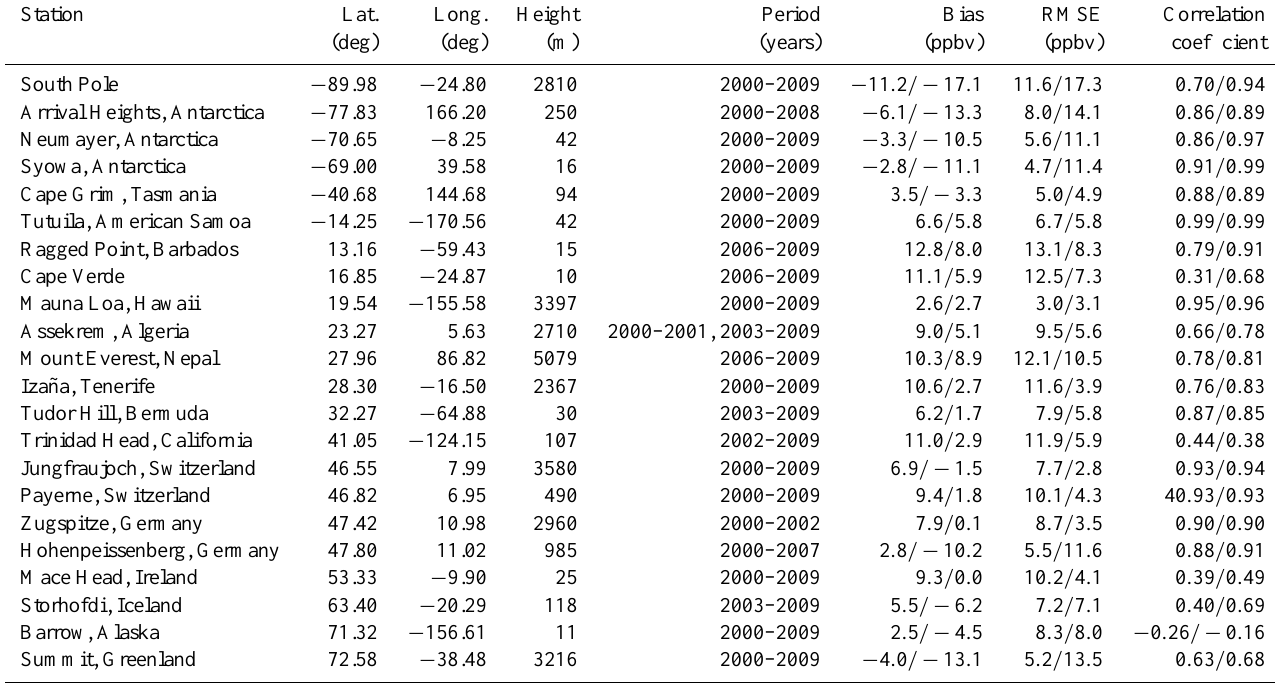
Table A5. List of stations used for the evaluation of the simulated surface O 3 mixing ratios. The mean bias and root mean square errors (RMSE) in the simulated monthly mean mixing ratios are indicated for the reference EC-Earth simulation and the corresponding ERA- Interim simulation. Also given are the linear correlation coefficients between the simulated and measured monthly mean concentrations. The results for the EC-Earth and ERA-Interim simulations are separated by a slash. Lat. Long.